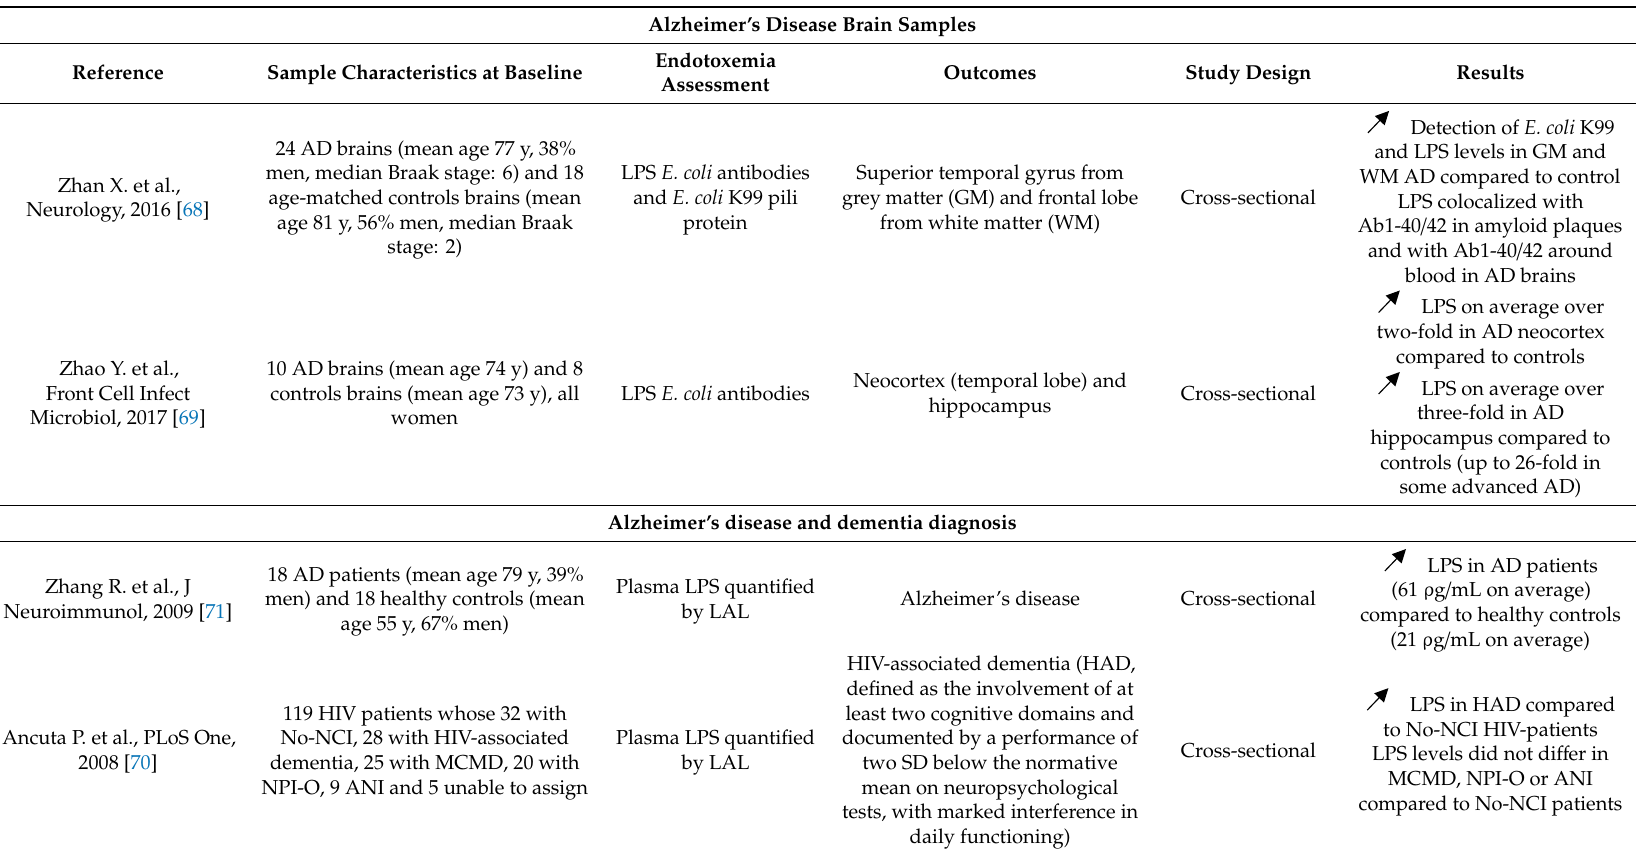
Table 4. Selective evidence on the association between lipopolysaccharides and dementia. Table 1. Selective evidence on the association between a single high-fat meal and metabolic endotoxemia.